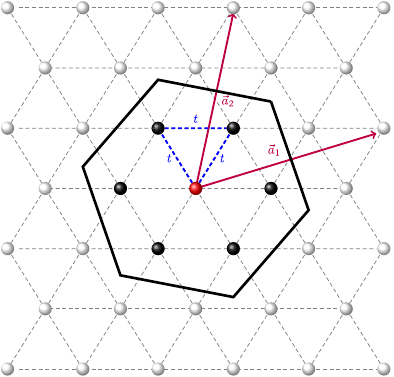
FIG. 16. Cluster geometry with N c ¼ 7 used in CDMFT. The cluster consists of a central site (marked in red) and six equivalent outer sites arranged on a ring. The translation vectors are ⃗ a 1 ¼